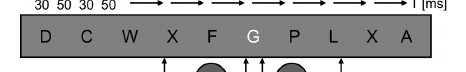
Figure 1 | Patients’ lesions and visual fields. (A) Horizontal MRI sections reveal the lesion that damaged the right occipital lobe in all three participants. (B) The visual field of the left, contralesional eye that was used for further testing was mapped at a Tübingen perimeter with a combination of dynamic and static perimetry; gray regions indicate the blind fields. The positions of the disks used in the experiments are projected onto the plots; the high-contrast one was shown to both hemifields, the low-contrast one to the sighted field only. Concentric circles indicate 10 ° , 20 ° , and 30 ° eccentricity.